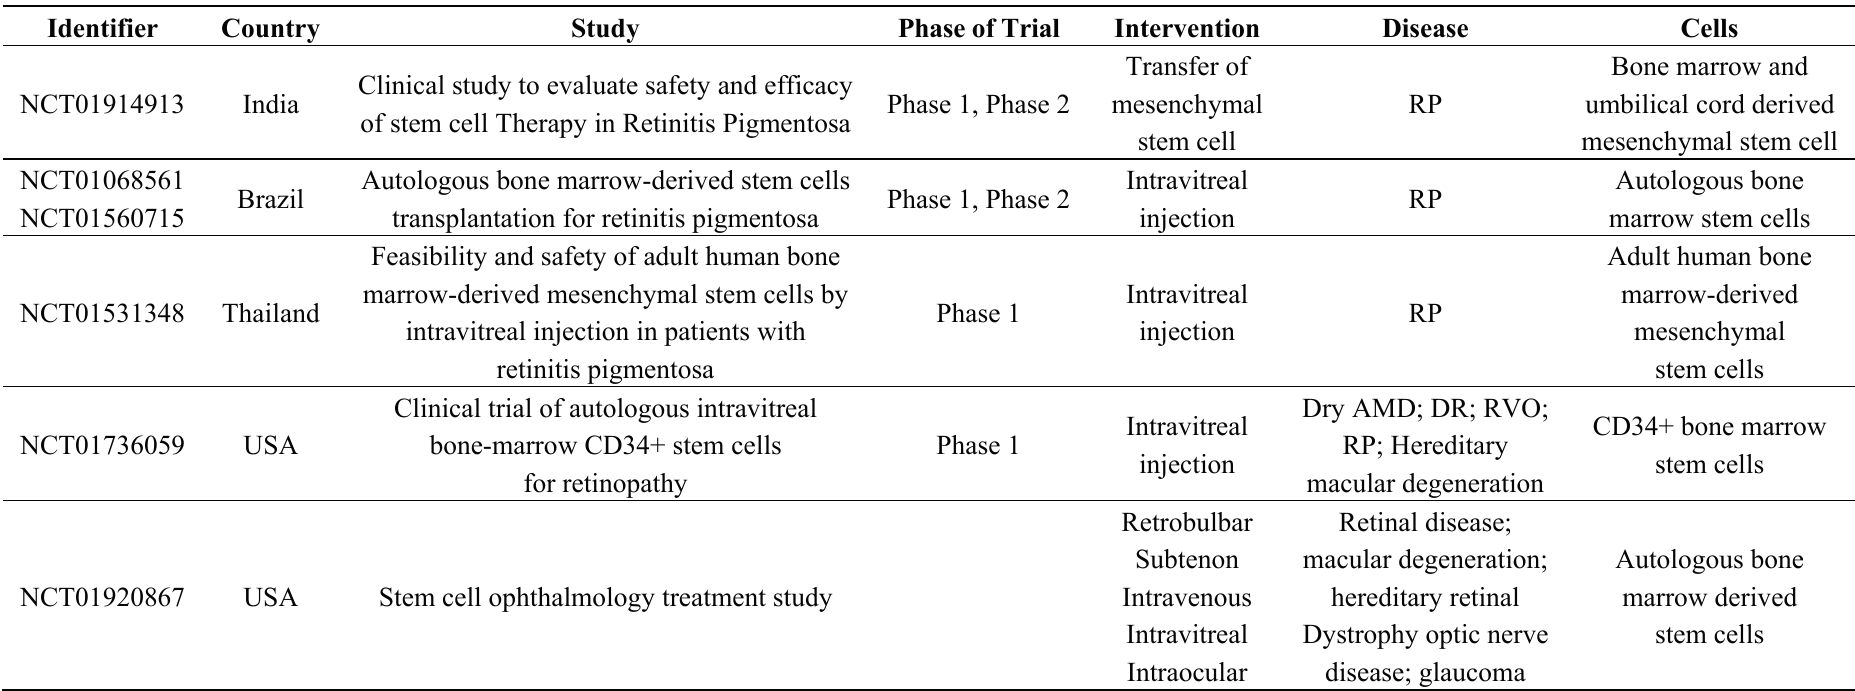
Table 3. Registered clinical trials on mesenchymal stem cells for retinal diseases. Information obtained from